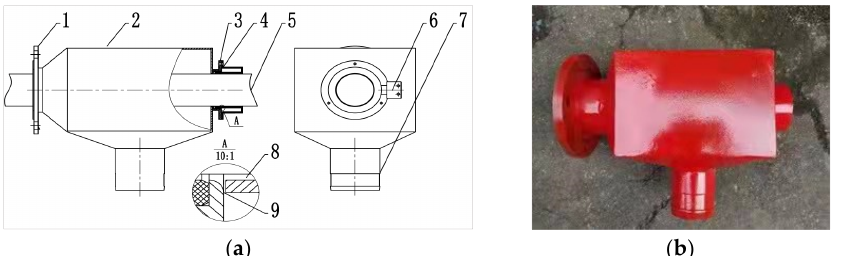
Figure 2. Structure of the dust hood: ( a ) structure chart: 1—mounting flange of the dust hood; 2—cavity of the dust hood; 3—unidirectional sealing ring; 4—dust control device; 5—drill pipe; 6—compressed air interface; 7—dust hood outlet; 8—gap between the drill pipe and the dust hood; 9—air slot of the sealing device; ( b ) real product.